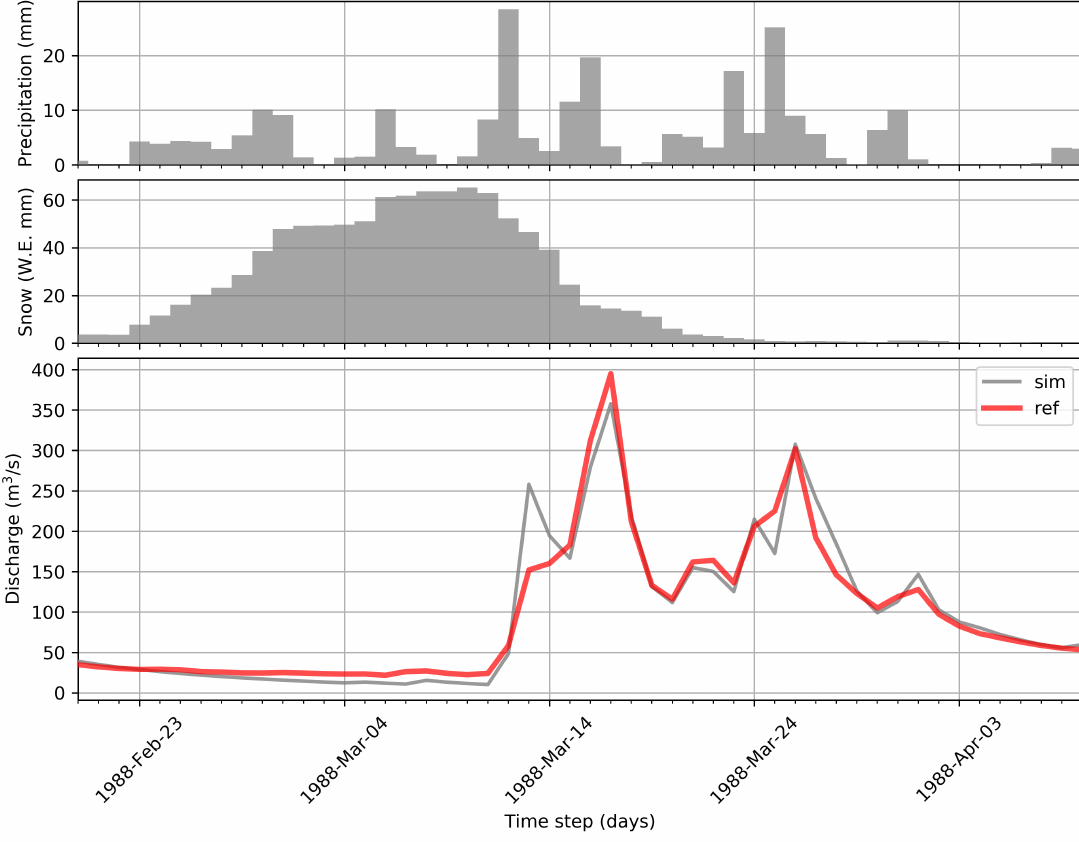
Figure 4. A validation period large snow melt event using